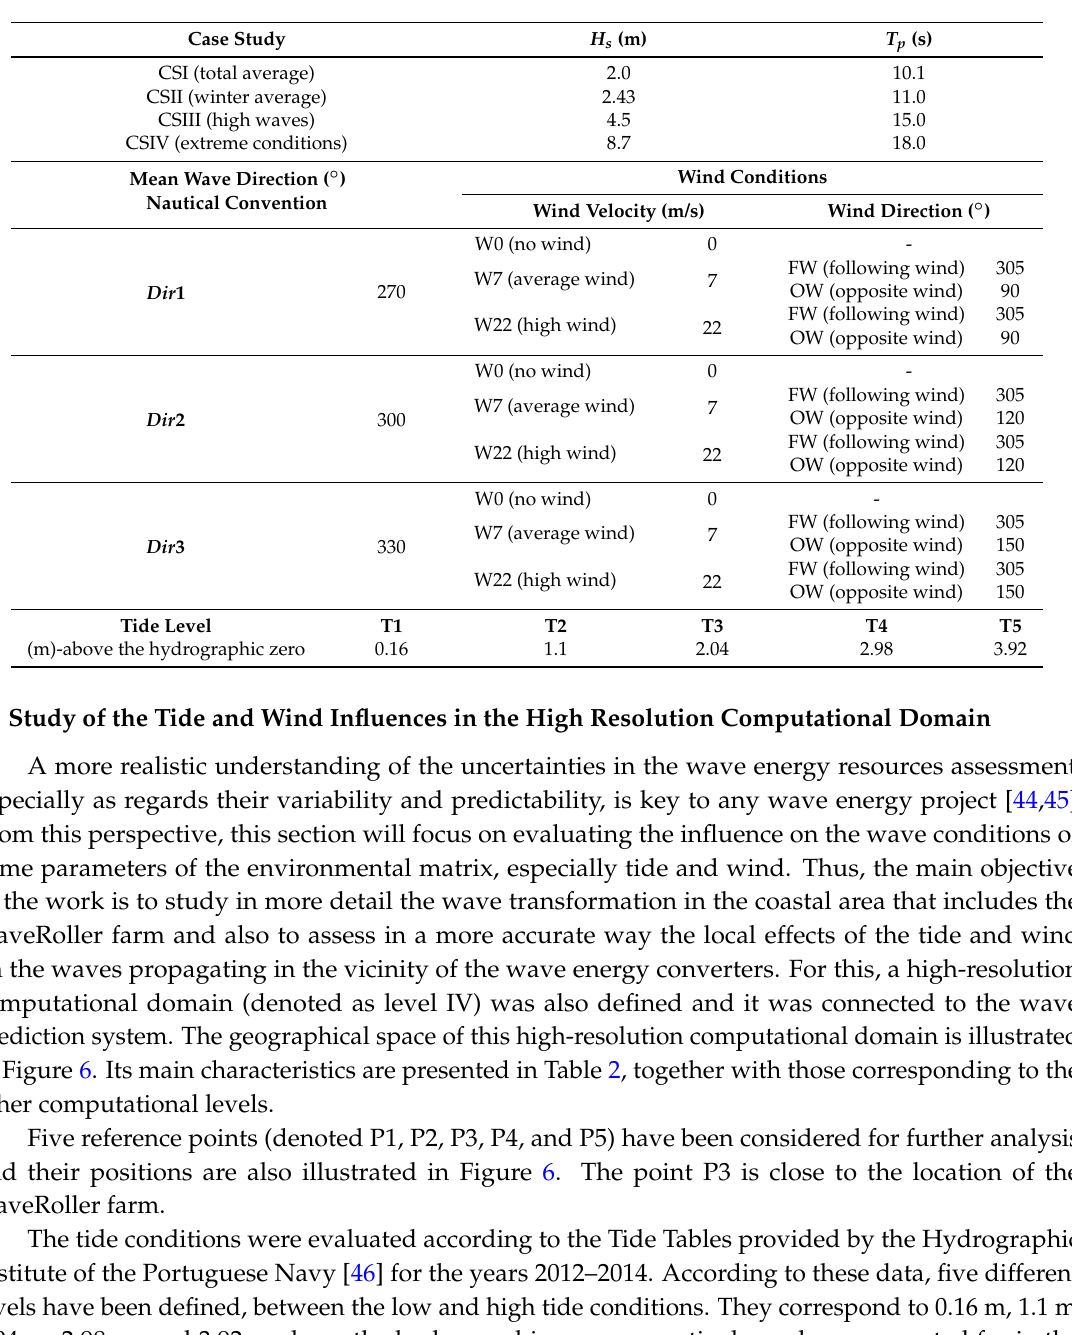
Table 3. Main characteristics of the four case studies considered (CSI, CSII, CSIII, and CSIV) in terms of the values of the parameters H s and T p and the subsequent parameterizations corresponding to each